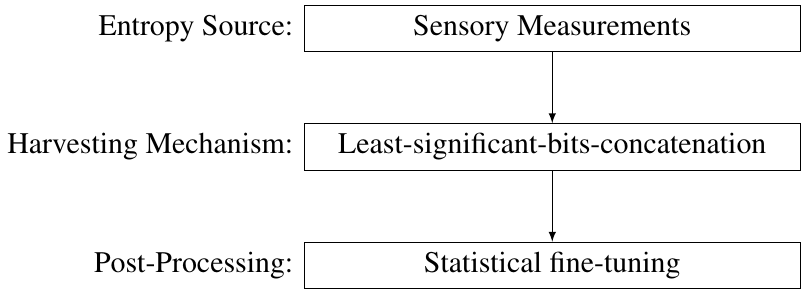
Figure 1. Simplified random number generation process with the particular building blocks proposed in this paper.